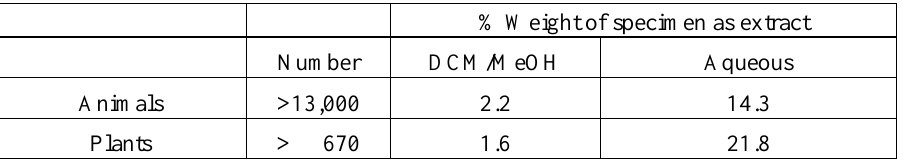
Table 5. Overall Average Yields from Marine